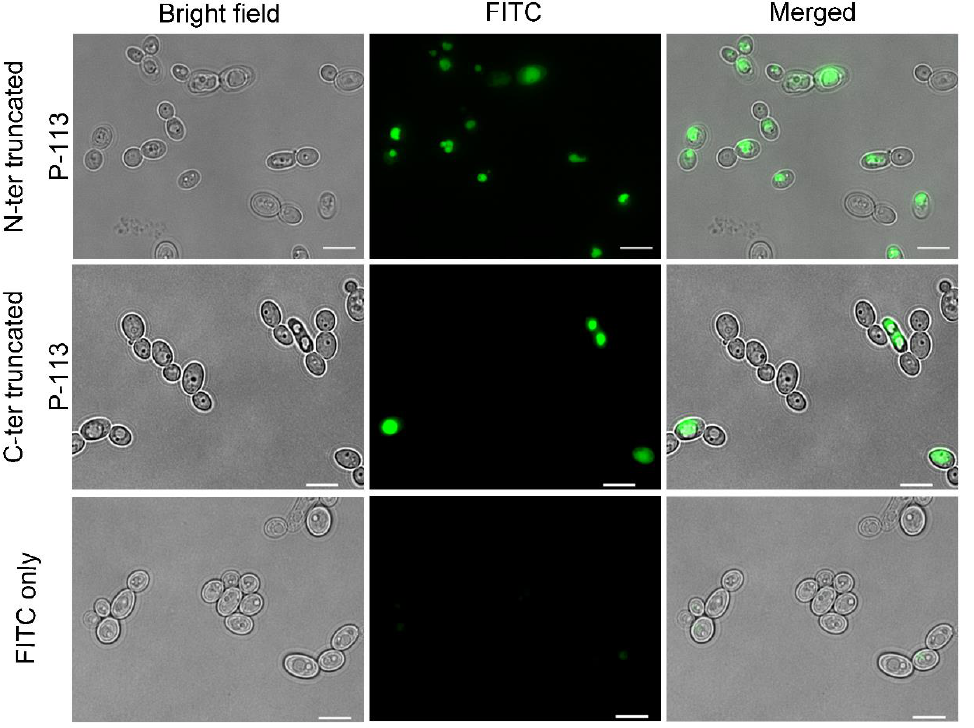
Figure 8. Localizations of FITC truncated P-113 peptides in C. albicans . Fluorescence microscopy of C. albicans (10 7 CFU/mL) incubated at 28 ℃ for 30 min with 50 μM of FITC-truncated P-113 or FITC only. The left panels show a bright field, the middle panels show FITC images, and the right panels show merged images. The bar corresponds to 5 μm.